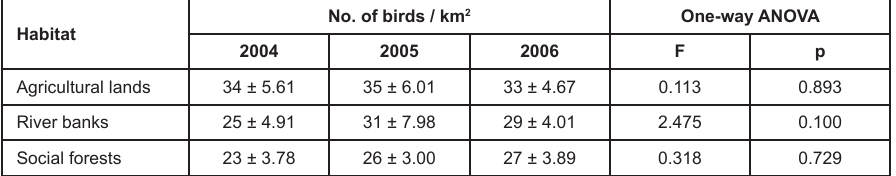
Table 1. Yearly variations in the density of the Indian Roller in the three habitats from 2004 to 2006.